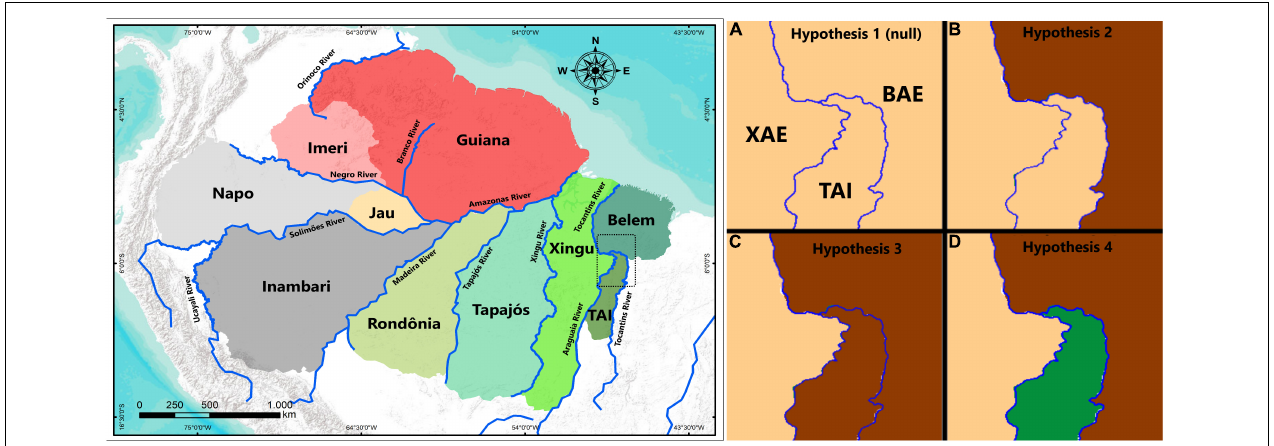
FIGURE 1 | Left: Amazonian areas of endemism according Silva et al. (2019), with the TAI shown in southeasternmost Amazonia. Right and clockwise: frames (A–D) of the four hypotheses of expected phylogeographic patterns for the TAI and neighboring areas (Belém Area of Endemism – BAE and Xingu Area of Endemism – XAE). (A) Hypothesis 1, all three areas are inhabited by genetically undifferentiated populations (assumed as the null hypothesis). (B) Hypothesis 2, TAI and XAE are inhabited by sister populations to the exclusion of BAE populations. (C) Hypothesis 3, TAI and BAE are inhabited by sister populations to the exclusion of XAE populations. (D) Hypothesis 4, TAI populations are inhabited by reciprocally monophyletic populations with respect to those in both BAE and